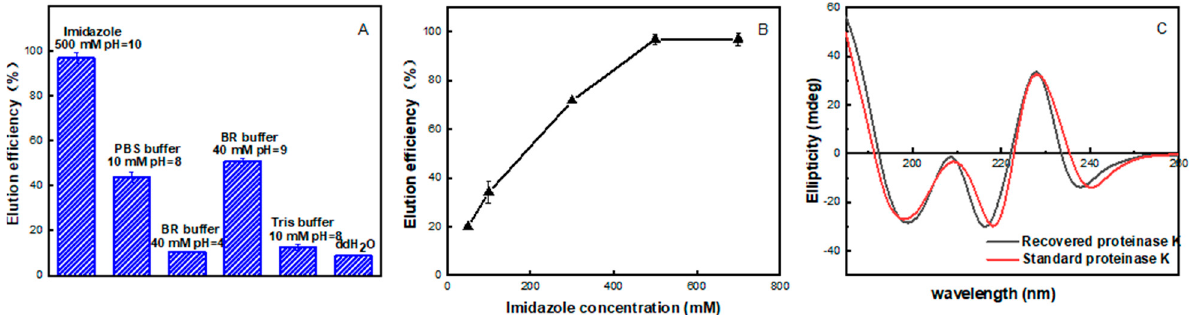
Figure 6. ( A ) Recovery of the adsorbed PrK using various stripping reagents. ( B ) Effect of imidazole concentration on elution efficiency. ( C ) Circular dichroic spectra of PrK. Protein solution: 100 μ g mL − 1 , 1.0 mL; pH 10.0; Co 4 PW–PDDVAC composite: 0.2 mg; stripping time: 30 min; stripping reagent: 500 mmol L − 1 , 1.0 mL.